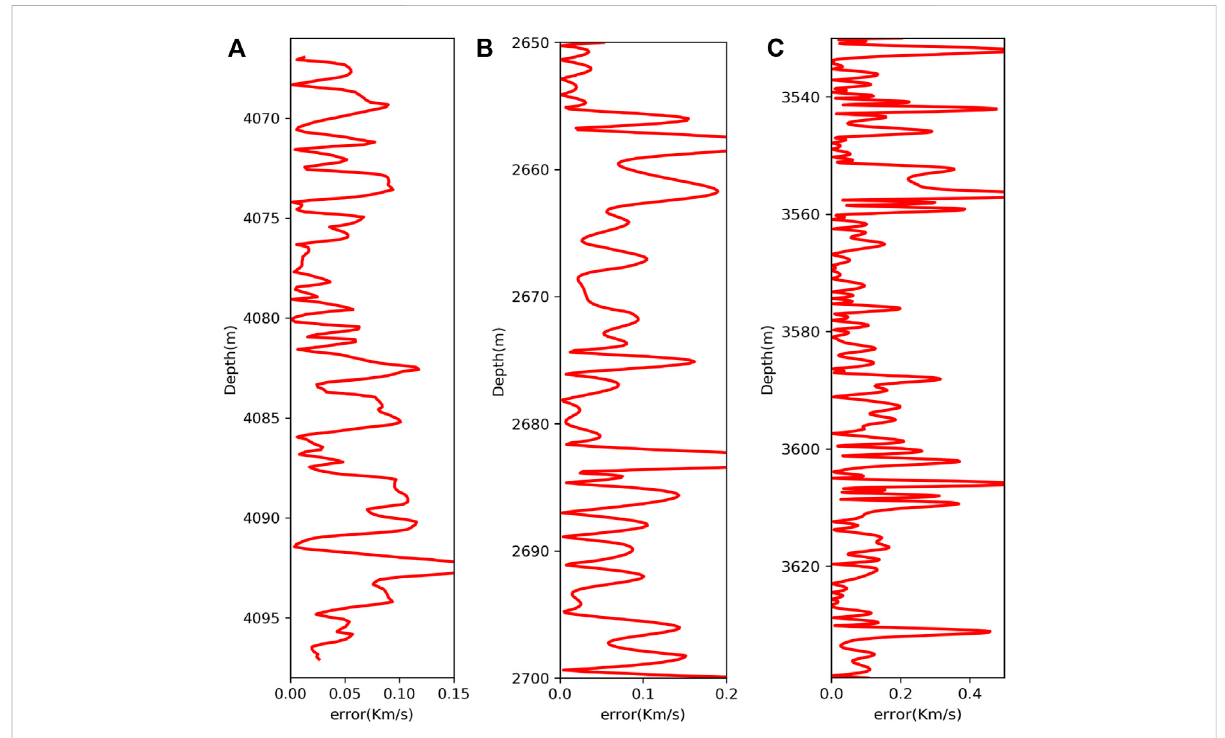
FIGURE 11 Absolute error curve of S-wave velocity predicted by DNN. (A) Well 1. (B) Well 2. (C) Well